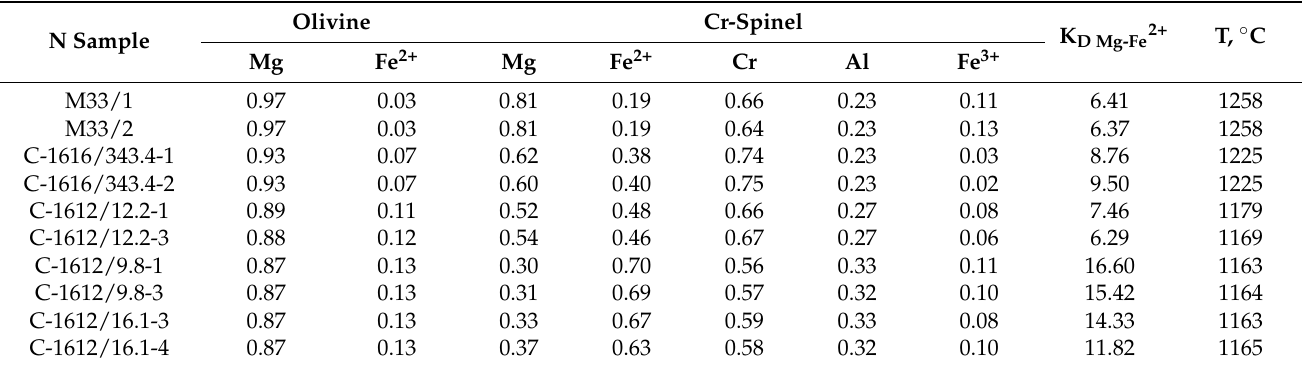
Table 3. Model equilibrium temperatures of coexisting olivines and Cr-spinels from ores and host dunites of the Sopcheozero deposit